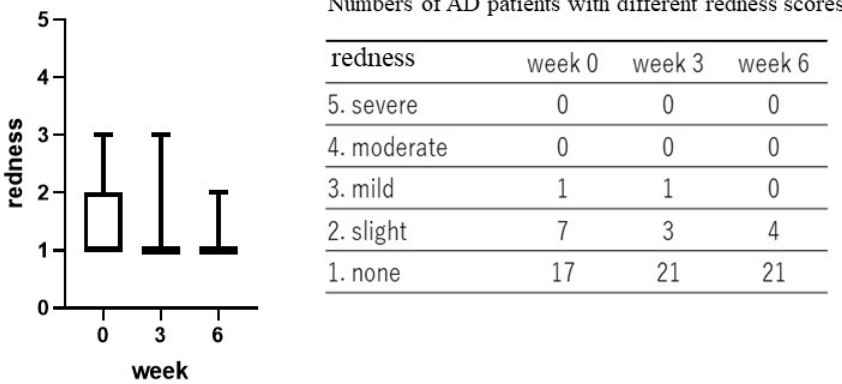
Figure 2. Clinical effects of the POLG nano-emulsion on redness of the skin of AD patients. Redness scoring was performed by a dermatologist (KN) at 0, 3, and 6 weeks on a 1–5 grading basis (1 = none; 2 = slight; 3 = mild, 4 = moderate; 5 = severe). n = 25. All data were analyzed using Dunn’s multiple comparisons test.